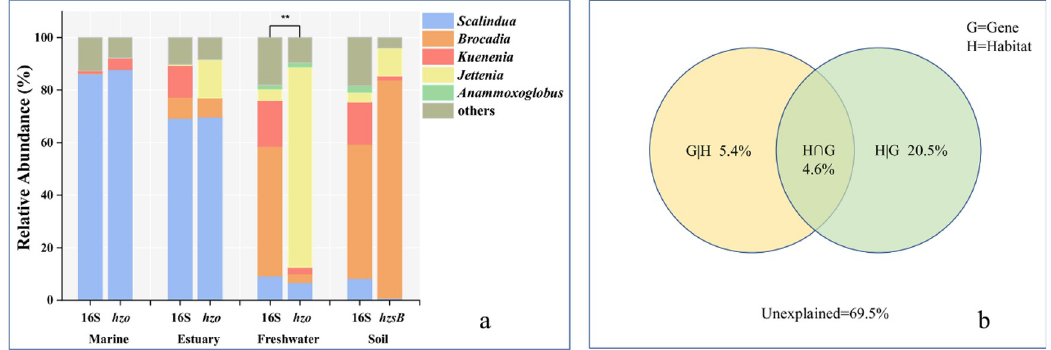
Fig 3. Community composition revealed by the most used two genes in each habitats (a), and Variation Partitioning Analysis (VPA) showing the relative role of habitat and marker gene on the structuring of the anammox bacterial community composition